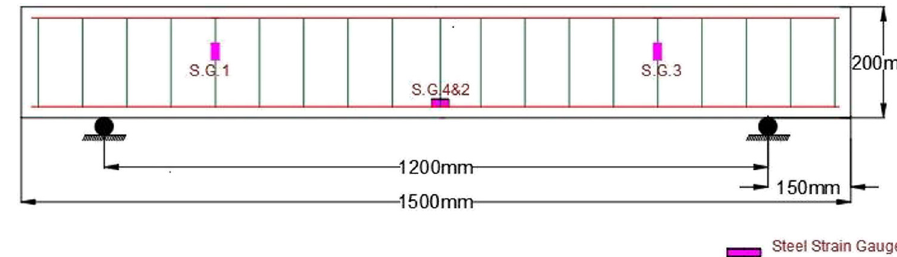
Figure 4: Locations of the steel strain